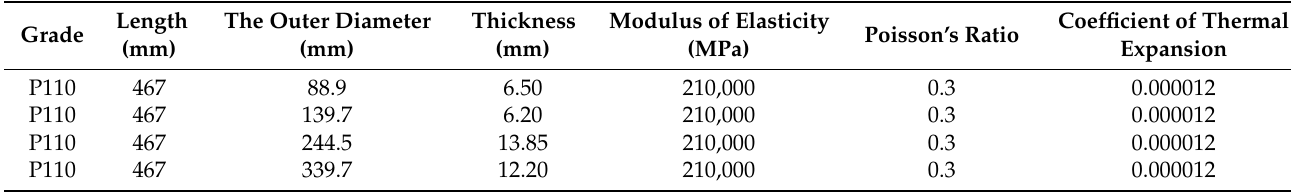
Figure 4. The casing actually adopted in the experiment. Table 1. Material properties of adopted casing.